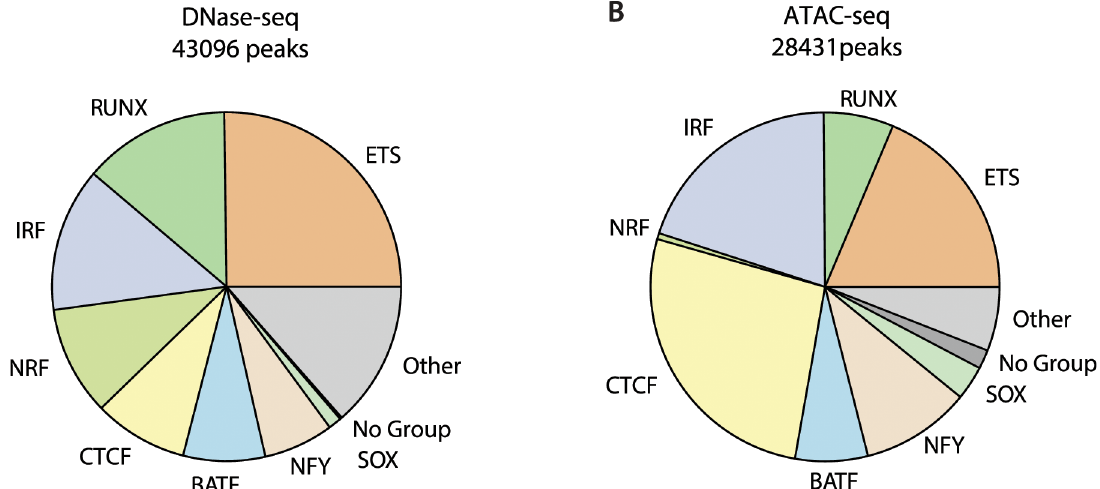
Fig 6. SeqGL identifies sequence signals underlying ATAC-seq peaks. Distribution of top-scoring TFs across (A) DNase-seq and (B) ATAC-seq peaks. TFs identified by SeqGL using ATAC-seq peaks are IRF, BATF and other cell-type factors that are strongly represented across peaks in both data types whereas NRF and CTCF show enrichment in DNase-seq and ATAC-seq respectively. The fraction of intergenic enhancer peaks is significantly higher in ATAC-seq, potentially explaining the higher occurrence of